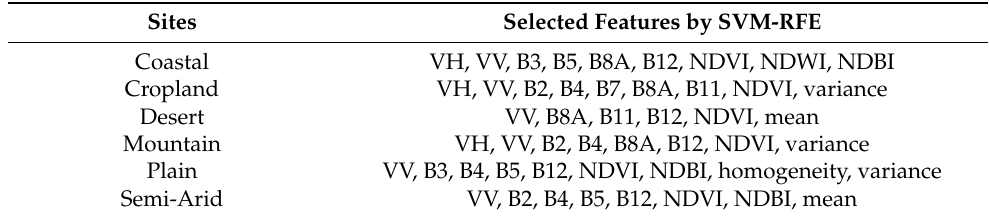
Table 4. Most informative features of each experiment site.